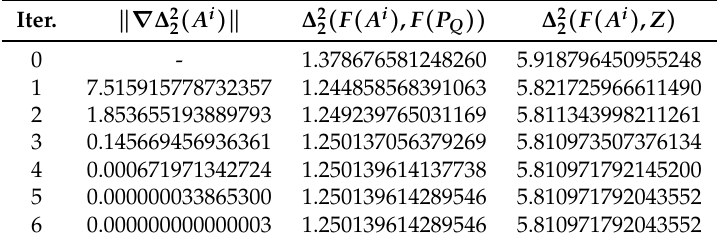
-Newton method for MOP (53), see Figure 14 . 2